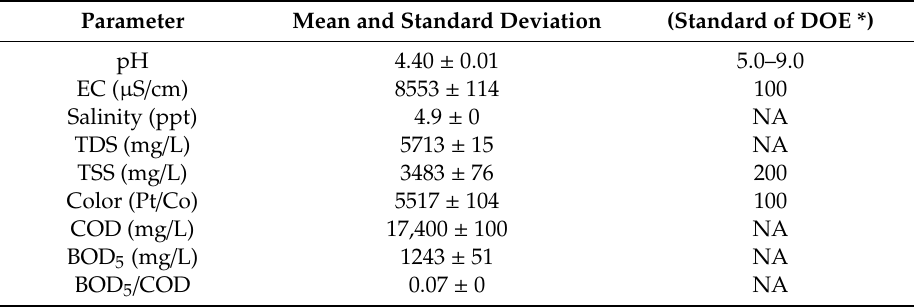
Table 2. Physico-chemical characteristics and heavy metals of palm oil mill e ffl uent